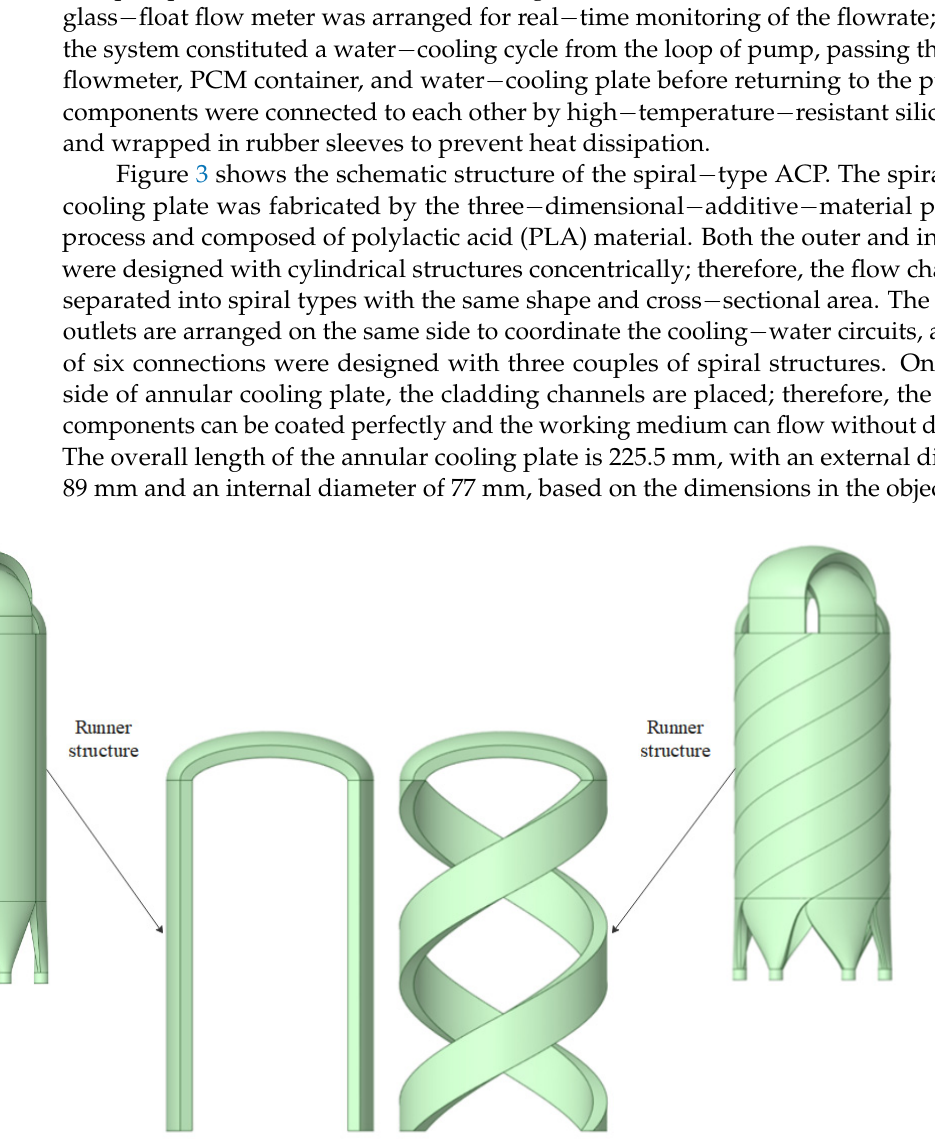
Figure 3. Schematic of spiral − ACP structure.